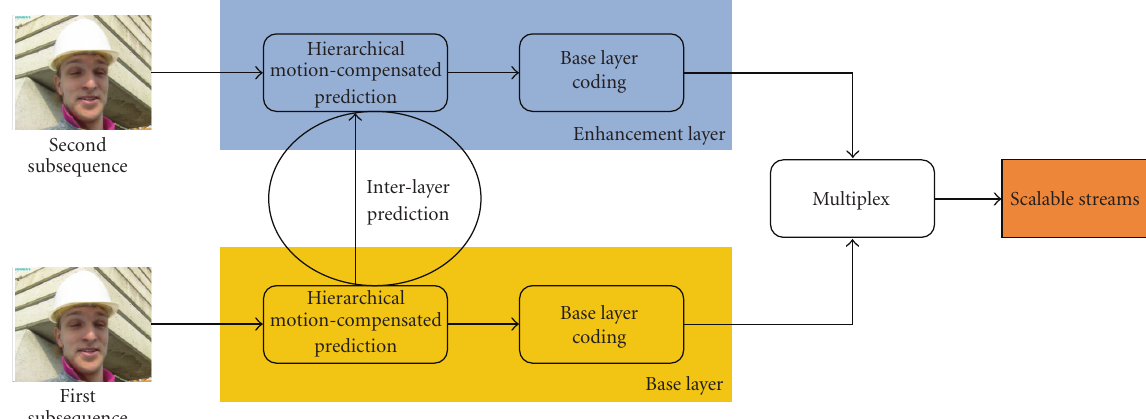
Figure 3: ILPS-MDSC with the interlayer prediction